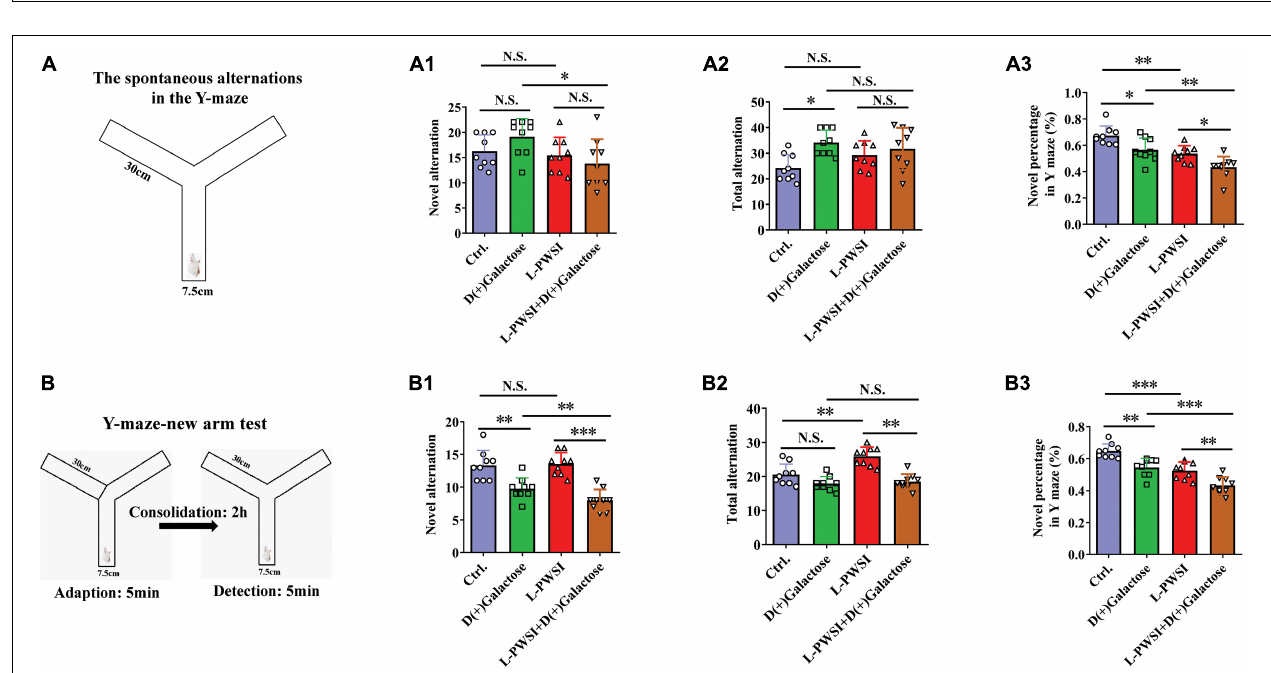
FIGURE 3 | The results of the Y-maze-spontaneous alternation test and New arm test in the D(+)Galactose, long-term post-weaned social isolation (L-PWSI), L-PWSI + D(+) Galactose and control groups of mice. (A) Schematic representation of the Y-maze-spontaneous alternation test. Means of novel alternation (A1) , total alternation (A2) , and novel percentage (A3) in Spontaneous alternation test. (B) Schematic representation of the Y-maze new arm test in the consolidation memory test. Means of novel alternation (B1) , total alternation (B2) , and novel percentage (B3) in New arm test. Data are presented as the mean ± SEM. from 9 mice in each group. ∗ represents p < 0.05; ∗∗ represents p < 0.01; ∗∗∗ represents p < 0.001; N.S., represents no significance.